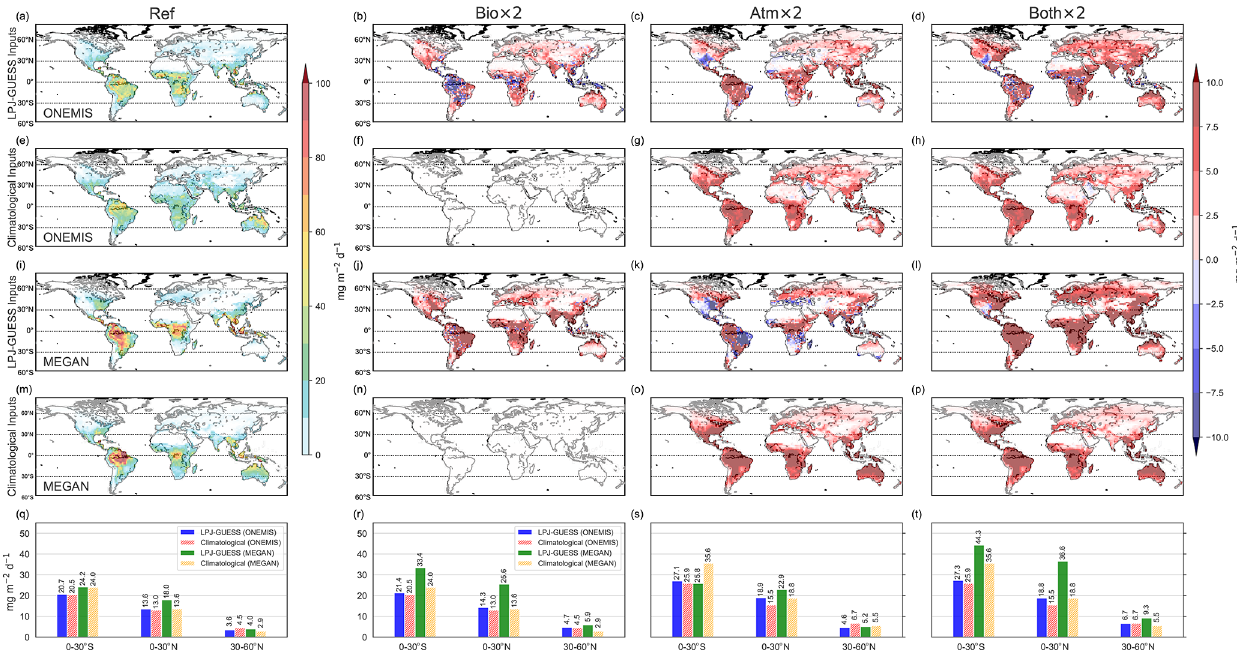
Figure 12. Global isoprene emission estimates from ONEMIS and MEGAN with LPJ-GUESS vegetation inputs and climatological inputs for the reference study (Ref) (a, e, i, m) and difference plots for Bio × 2 (b, f, j, n) , Atm × 2 (c, g, k, o) and Both × 2 (d, h, l, p) . The panels at the bottom (q, r, s, t) display the emission flux averages (in mgm − 2 d − 1 ) over the latitude bands 0–30 ◦ S, 0–30 ◦ N, 30–60 ◦ N.